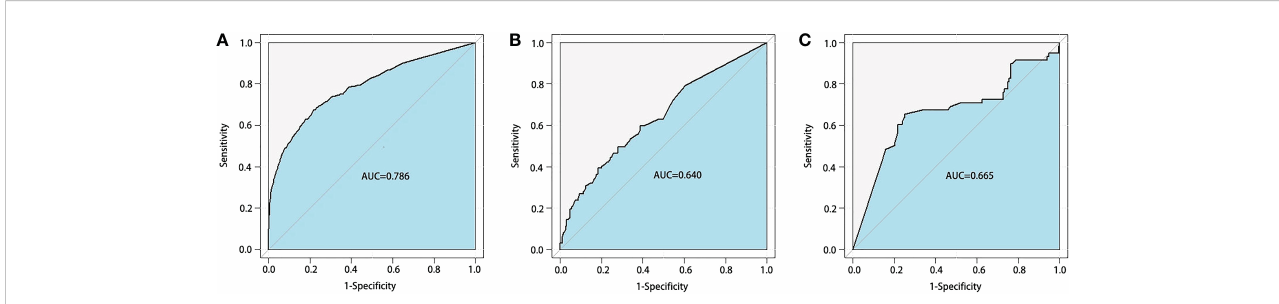
FIGURE 3 Receiver operating characteristics curves of random forest model for BLADE scoring system. The areas under the curve (AUCs) were 0.786 in the training set (A) 0.640 in the test set (B) and 0.665 in the external validation set (C) BLADE, blood loss and duration of